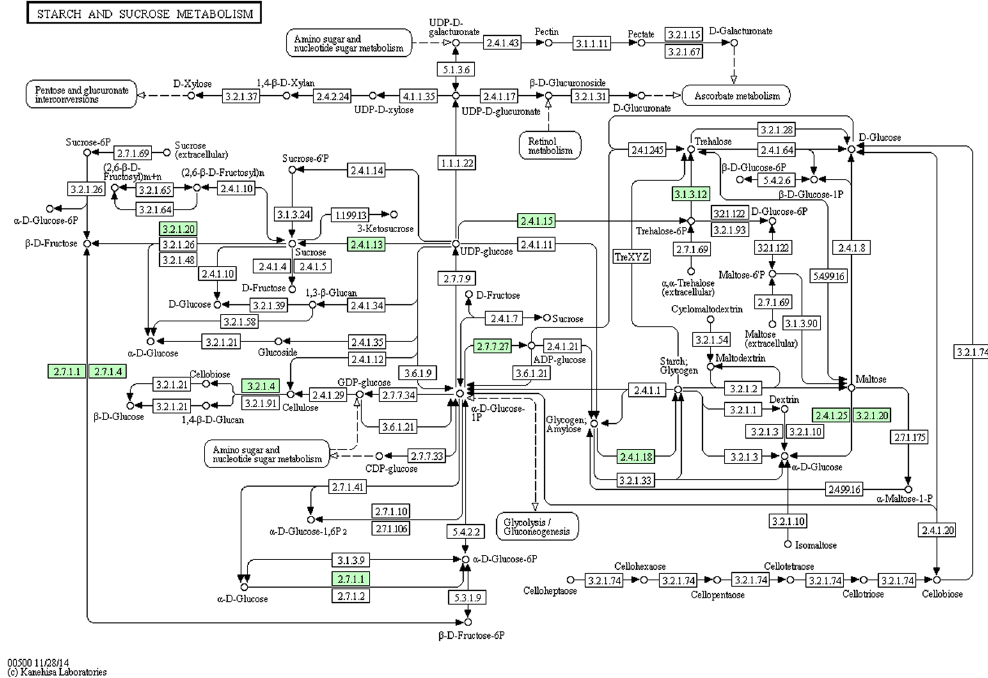
Figure 5. KEGG pathway annotation: starch and sucrose metabolism. The green number represents the differentially expressed proteins. These proteins are queried by http://www.kegg.jp/kegg-bin/show_ pathway?ko00500 +